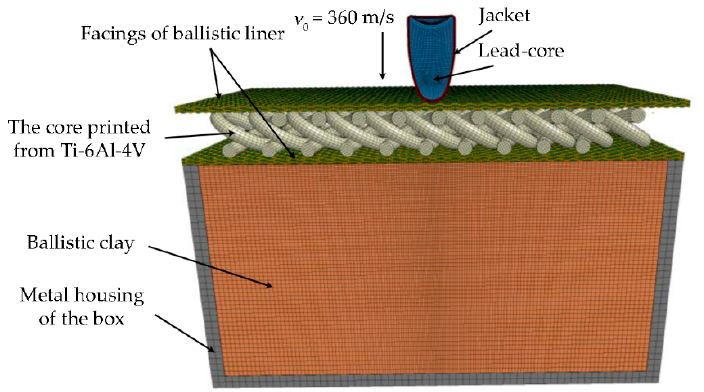
Figure 9. Numerical model of the analyzed projectile impact